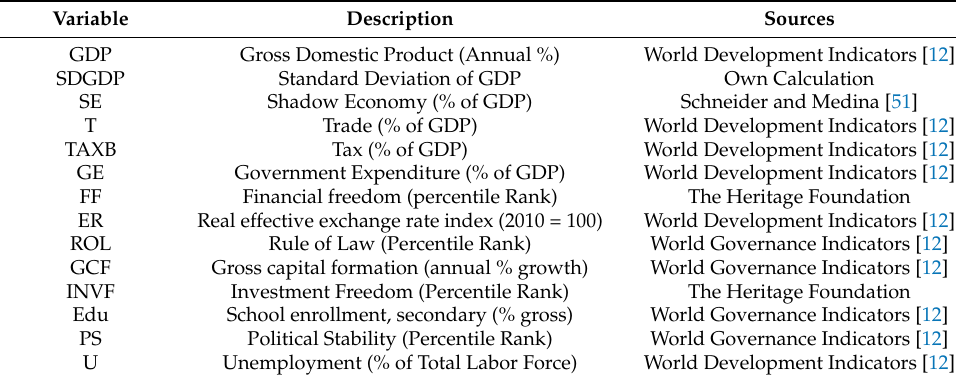
Table A1. List of